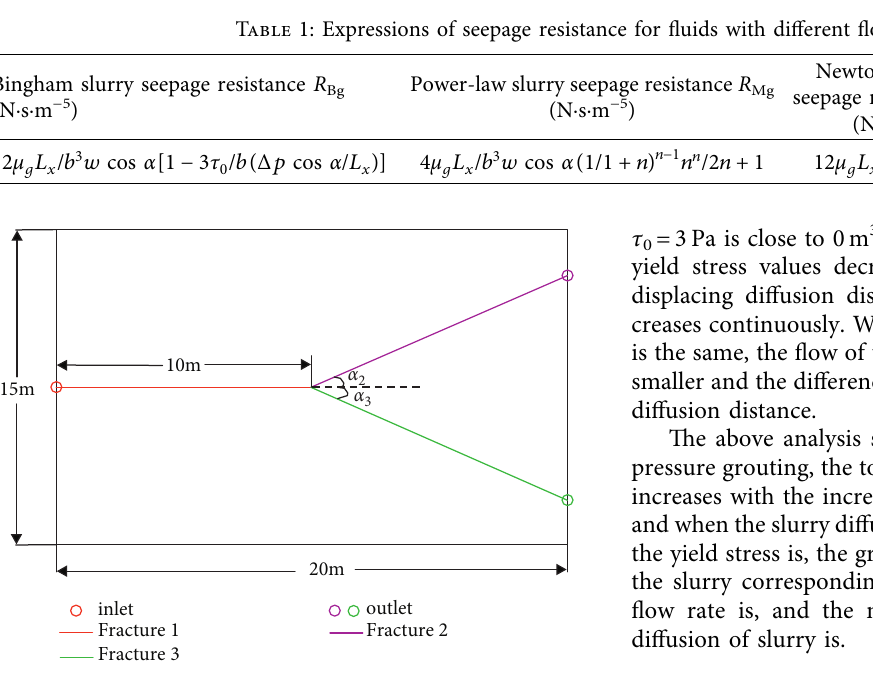
Figure 3: The herringbone fracture structure schematic diagram. Table 2: Parameters of water-displacing grouting in the herring- bone